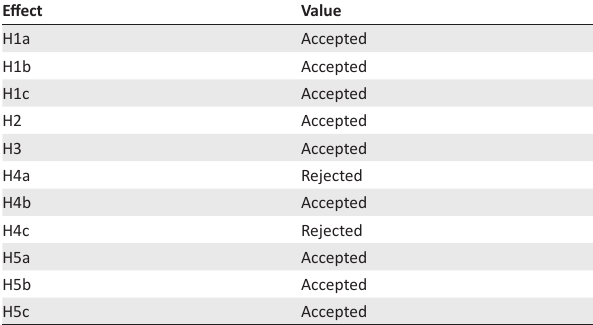
TABLE 7: Summary of the results on our